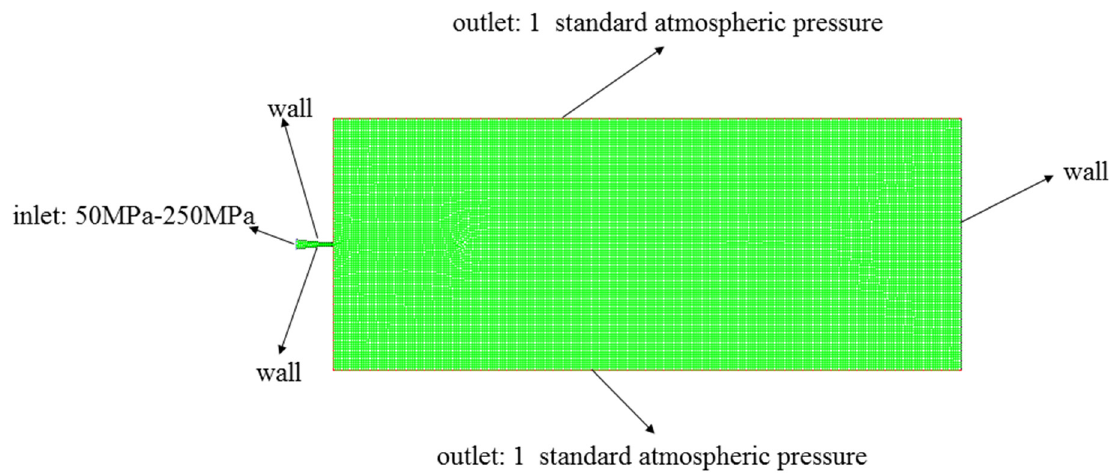
Figure 7. Finite element model for high pressure water jet process.